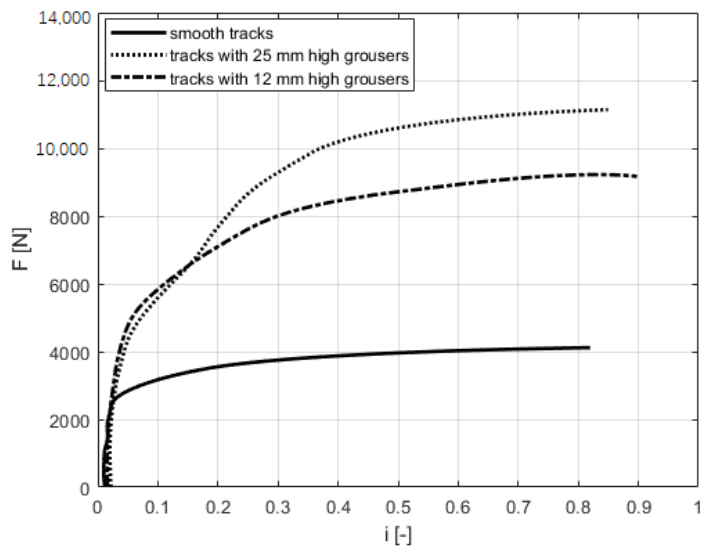
Figure 19. Traction force-slip curves on